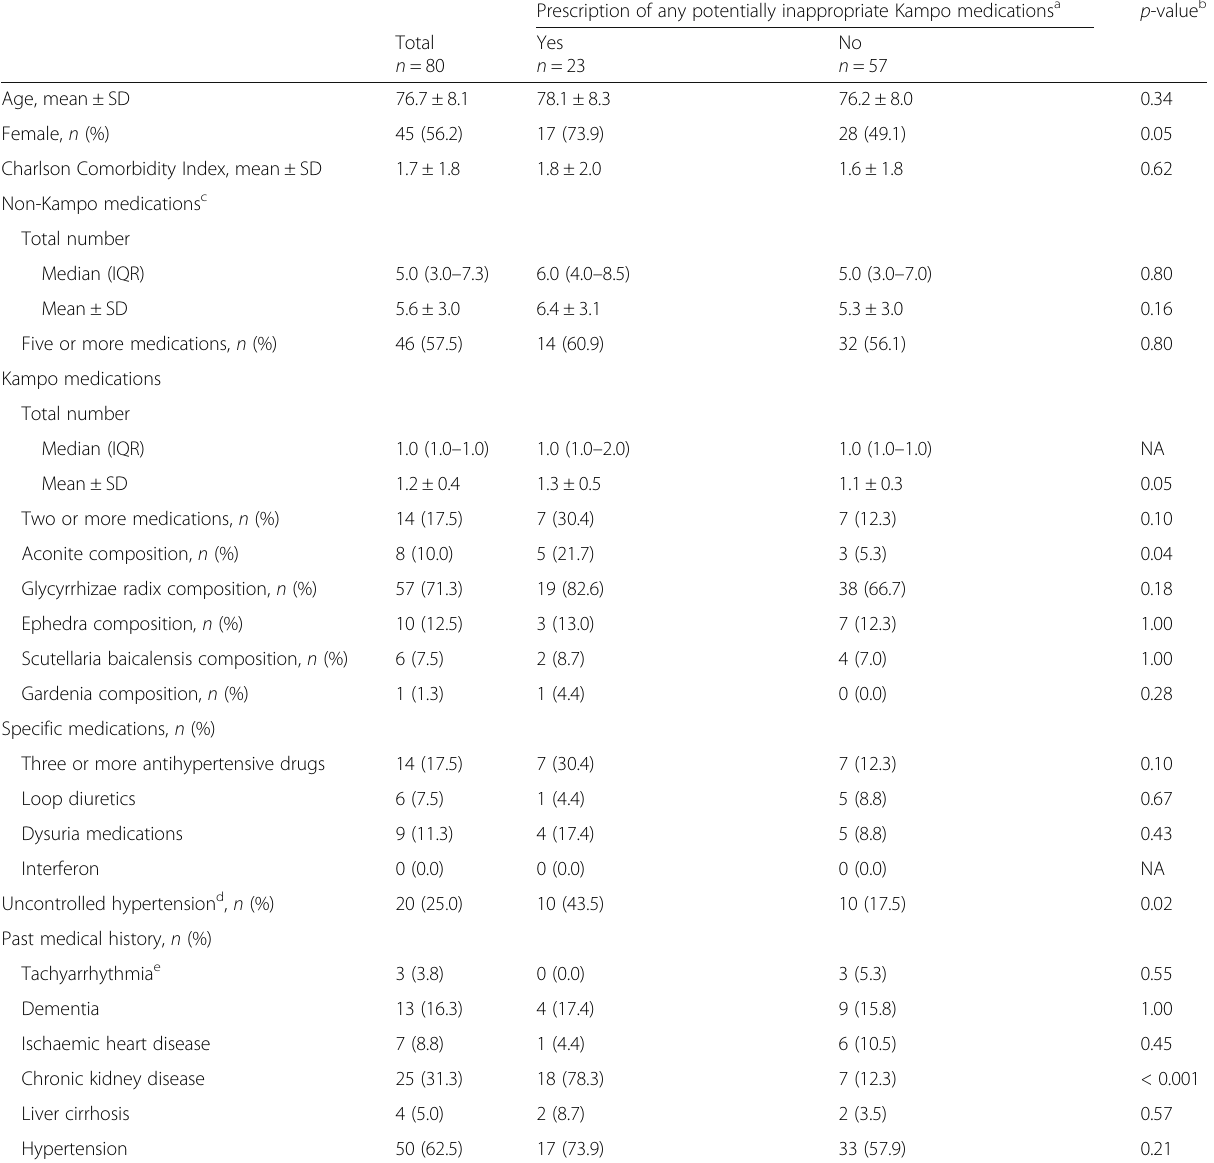
Table 2 Characteristics of the elderly ambulatory patients and the comparison of patients who were prescribed any potentially inappropriate Kampo medications to be used with caution and those who were not Prescription of any potentially inappropriate Kampo medications